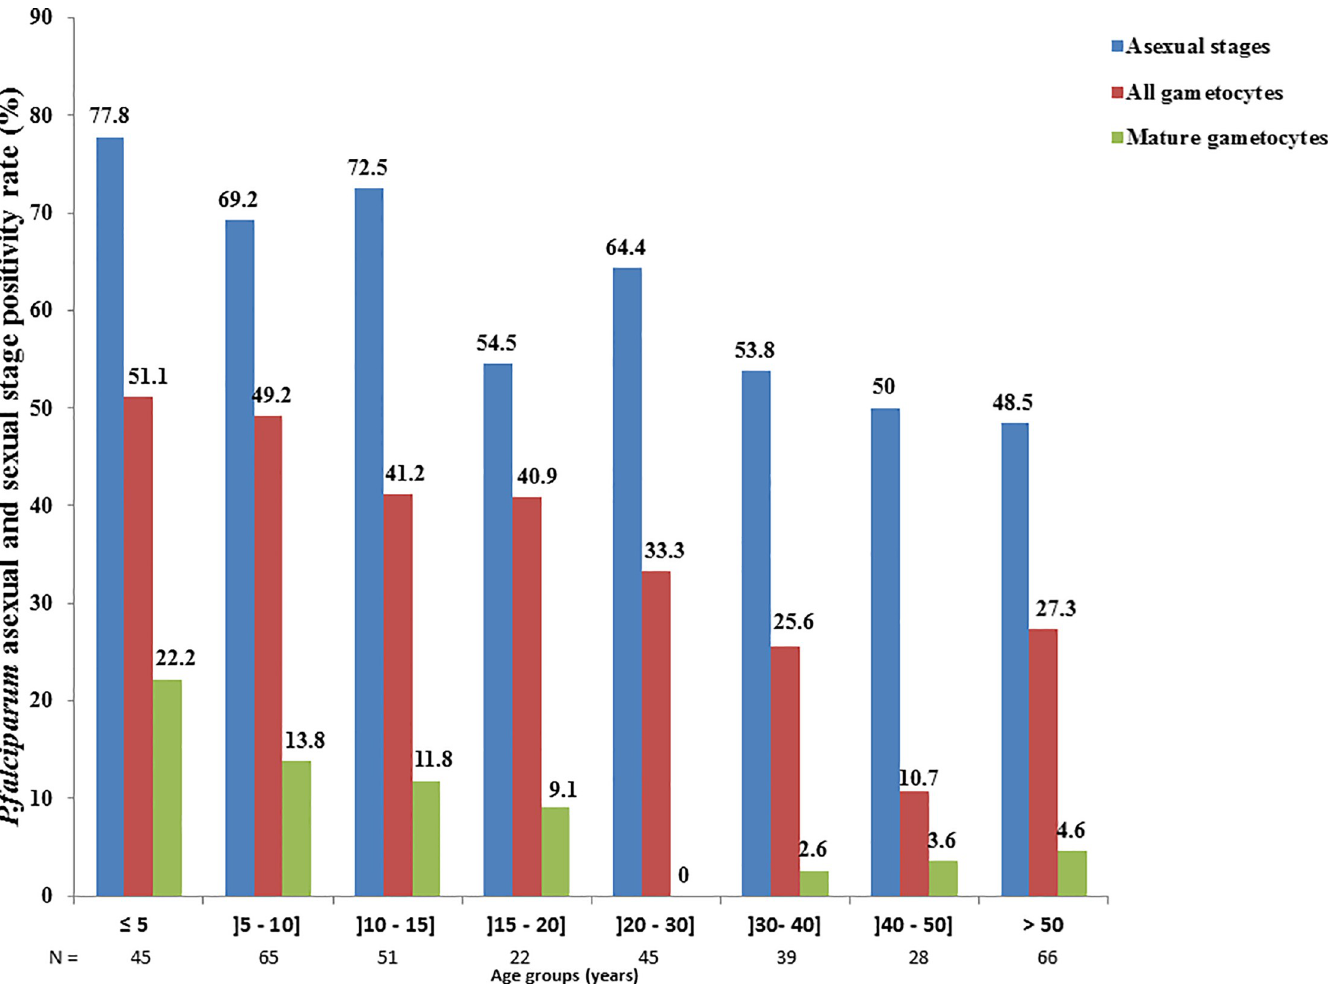
Fig 1. P . falciparum asexual and sexual stage positivity according to age. Data showing declining gametocyte positivity (all stage and mature gametocytes) with age. All stage gametocyte positivity was determined by RT-LAMP targeting the pan-gametocyte marker, Pfs16 , whereas mature gametocyte carriers were identified by Pfs25 - based RT-PCR. Similarly, positivity for P. falciparum asexual stages was determined by RT-LAMP targeting the asexual stage-specific marker, PfExp1 .